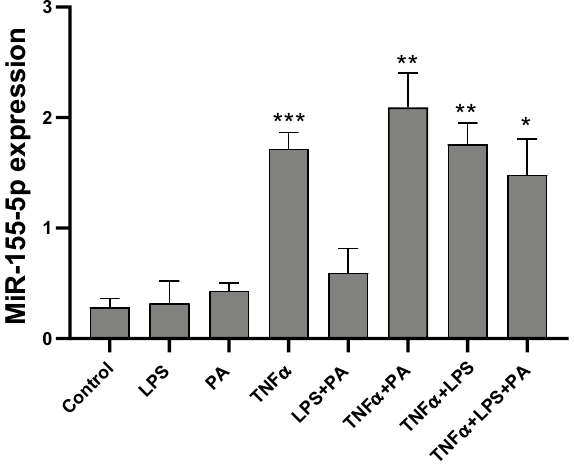
Figure 3. MiR-155-5p expression in 3T3-L1 adipocytes. Differentiated 3T3-L1 adipocytes were treated with 100 ng/ml LPS, 750 µM PA and 10 ng/ml TNFα or a combination of these compounds. MiRNA expression was quantified using qRT-PCR. Results are expressed as the mean ± SD of triplicate experiments. Significance is depicted vs. control. *p < 0.05, **p < 0.01, ***p < 0.001. Abbreviations: lipopolysaccharide, LPS; palmitic acid, PA; tumor necrosis factor alpha,